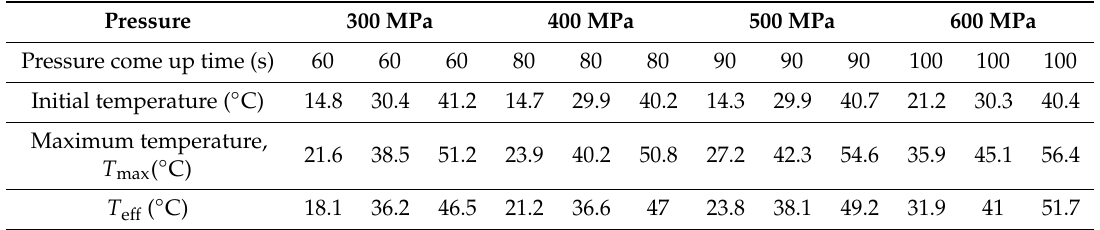
Table 1. HPP conditions at di ff erent temperatures and the corresponding parameters.